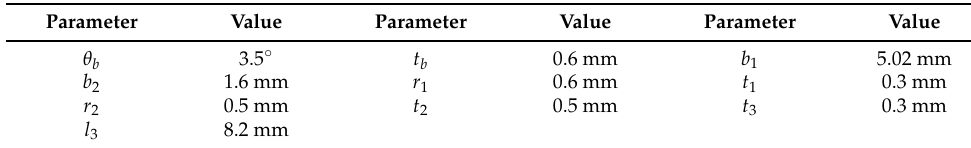
Table 3. Optimized structural